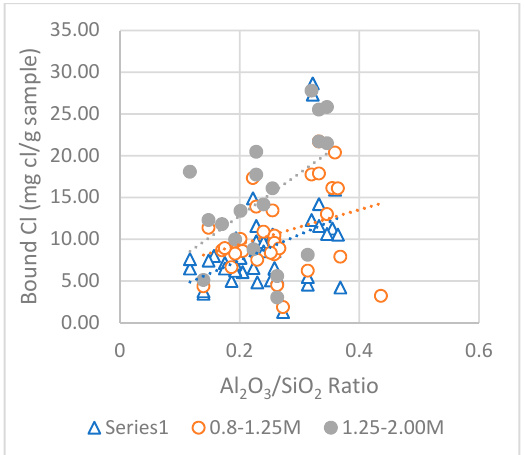
Figure 14. Relation between Al 2 O 3 /SiO 2 ratio and bound chloride for different chloride concentra- tions for all data.